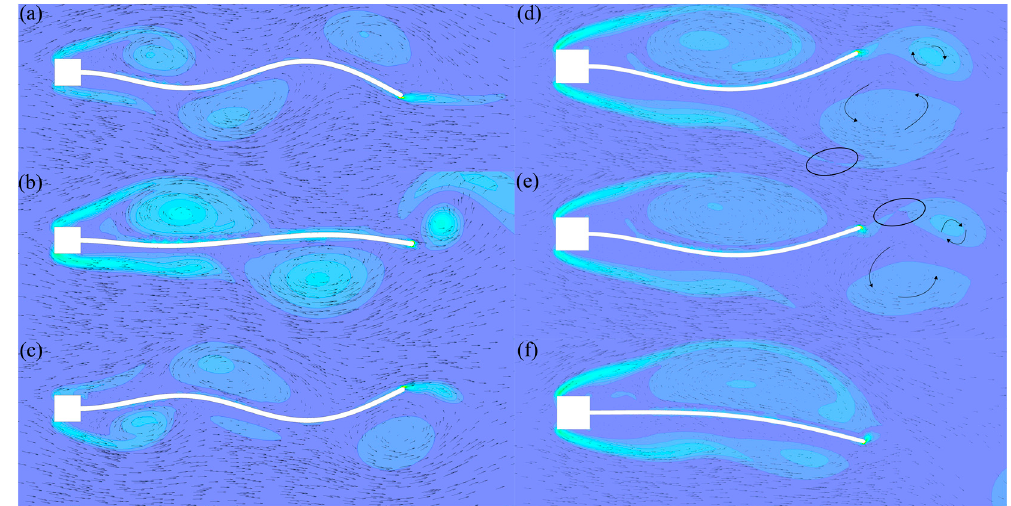
Figure 20. Vortex shedding for the L = 100 mm, t p = 600 µm plate at u f = 40 m/s, ( a – c ), D = 8 mm ( d ), ( e , f ) D = 12 mm.